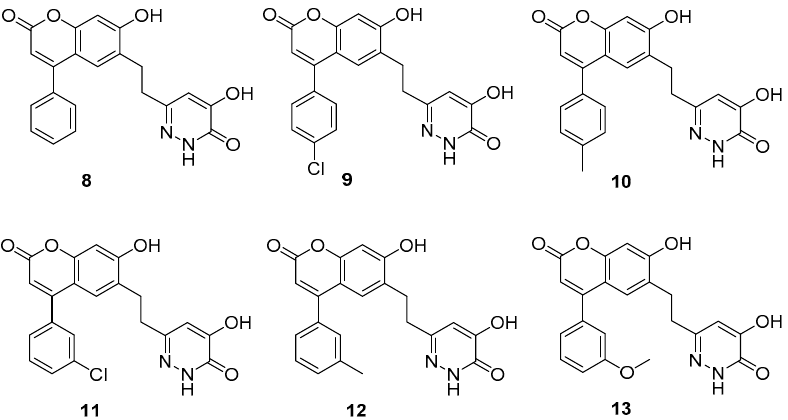
Figure 3. Prepared derivatives of compound 8 monosubstituted at the aromatic part.